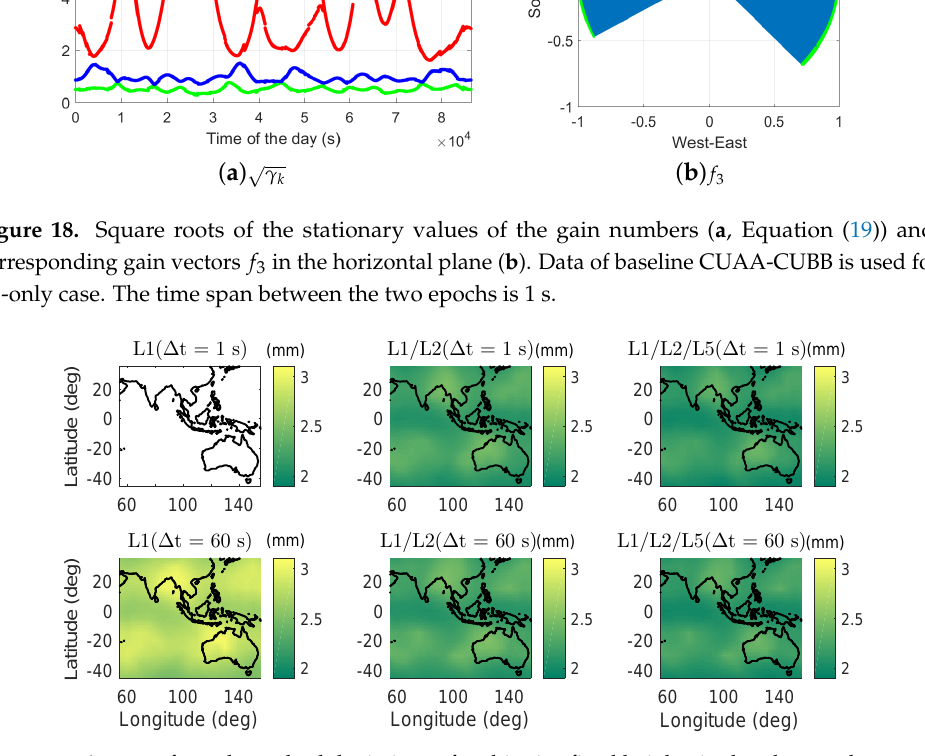
Figure 19. Average formal standard deviations of ambiguity-fixed heights in the phase-only two-epoch case. The time span between the two epochs are 1 ( top ) and 60 s ( bottom